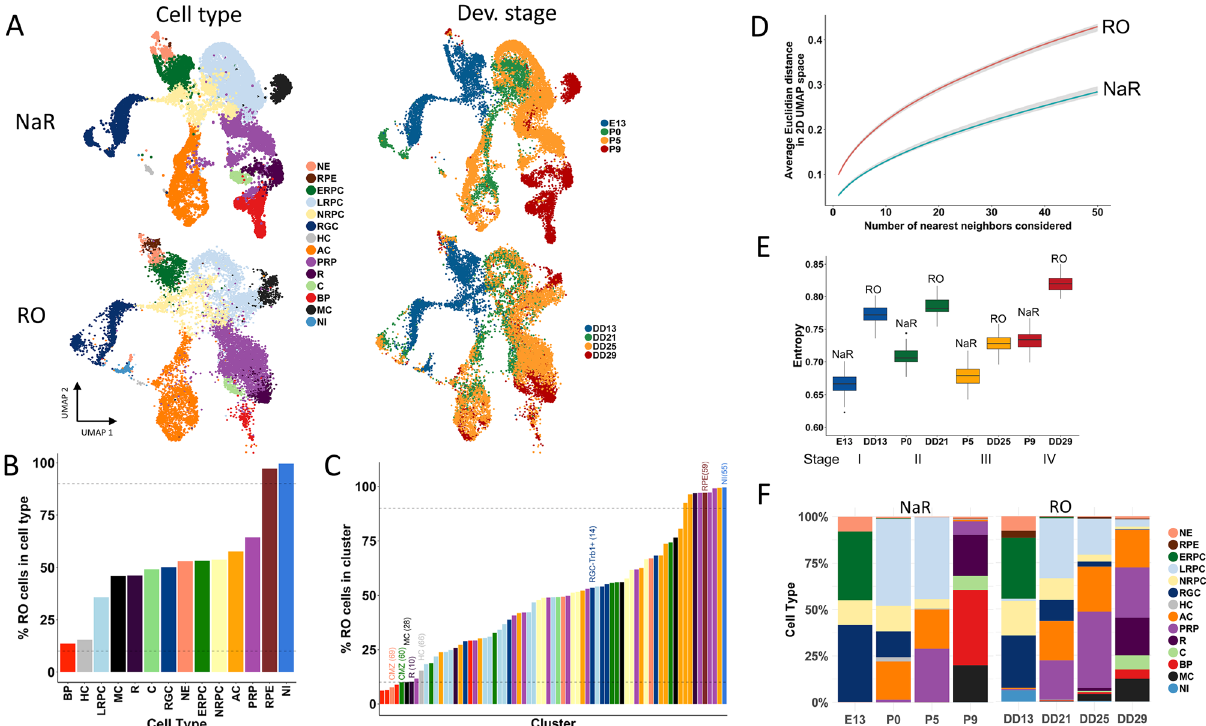
Figure 2. Comparison of NaR and RO cells in scRNA-Seq-based UMAP space. ( A ) Distribution of NaR (upper) versus RO (lower) cells across the UMAP manifold, sorted by cell type (left) and developmental stage (right). ( B , C ) Proportion of RO cells (adjusted for number of NaR and RO cells) in 13 cell types ( B ), and 71 clusters ( C ). 86% of cell types and 82% of clusters contain at least 10% of the least represented cell origin (NaR vs RO). Cell types are colored as in ( A ) and clusters are colored according to the cell type to which they were assigned. Notable clusters discussed in the main text are highlighted. ( D ) Larger average distance in 2D UMAP space (Y-axis) from n nearest neighbors (X-axis) for RO (red) than for NaR cells (blue). ( E ) Larger cell type diversity (sampling-based measure of entropy) in the four developmental stages for RO than for NaR. Developmental stages are colored-coded as in ( A ). ( F ) Proportions of cell types within a developmental stage for NaR (left) and RO